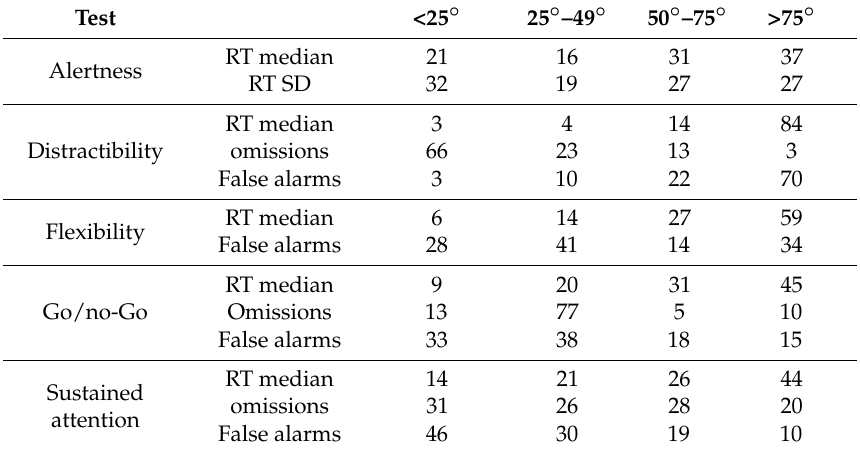
Table 4. Distribution of children’s performance in standardized tests by percentile